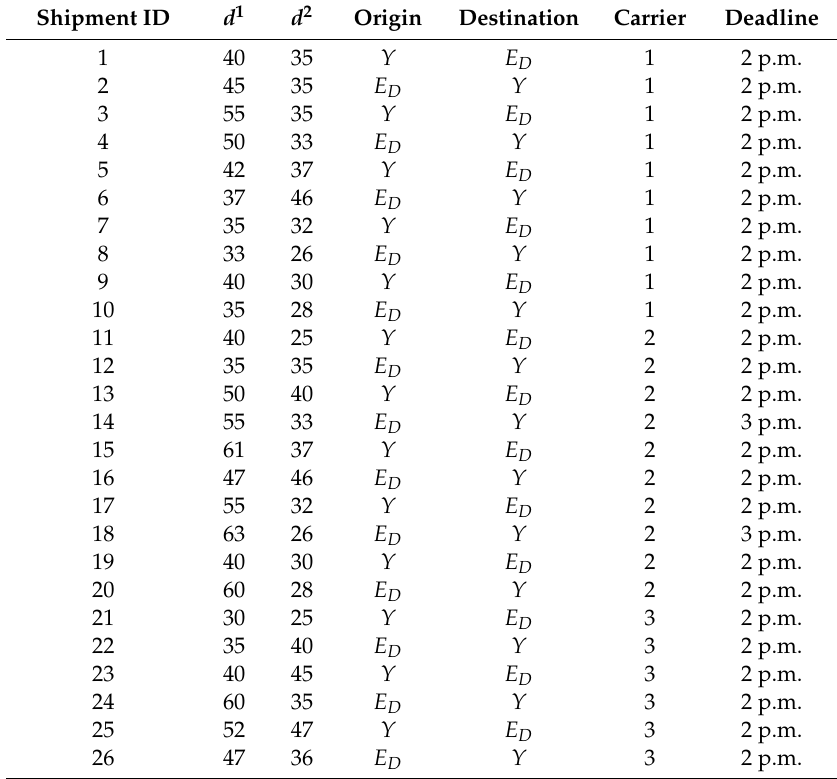
Table 4. Input data for the shipments in the small-scale